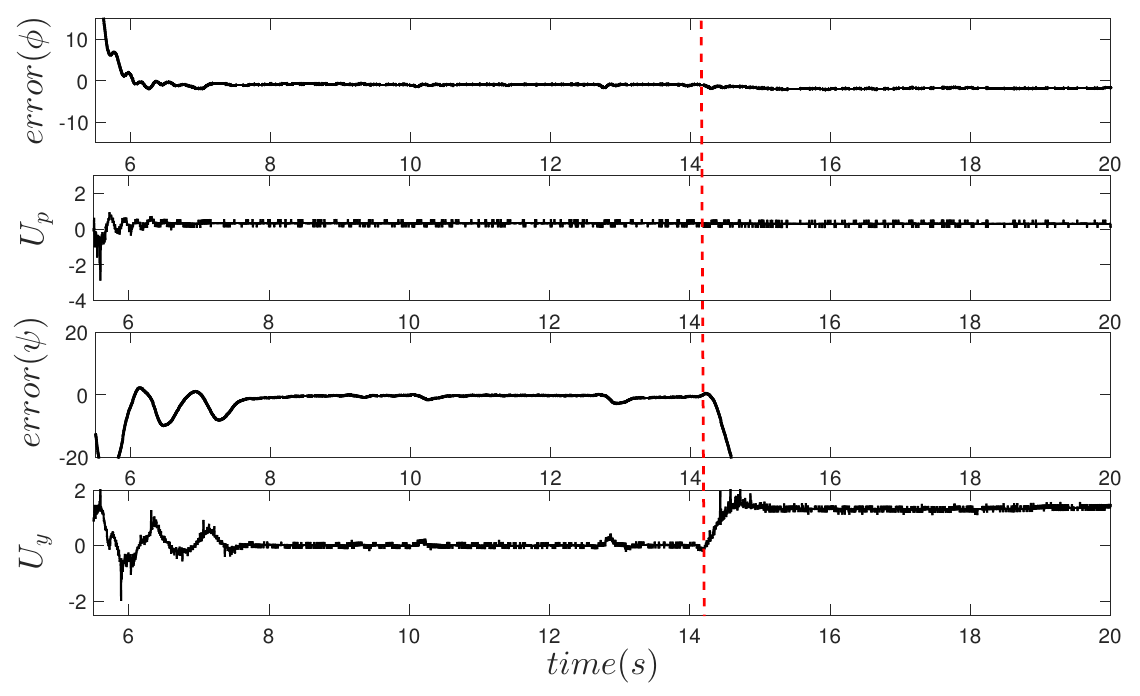
Figure 14. Response to the presence of failure in actuator f a 2 of